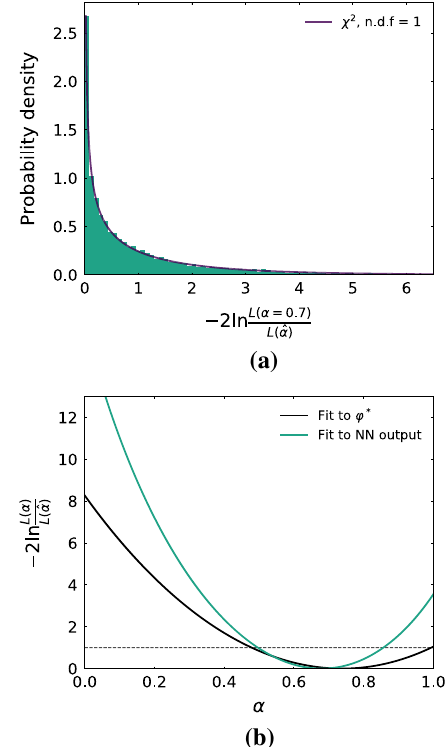
Fig. 6 a Distribution of the log-likelihood ratio − 2ln ( L (α = 0 . 7 )/ L ( ˆ α)) for the 10 , 000 test sets generated with α = 0 . 7. Overlaid is a χ 2 distribution for one degree of freedom. b Comparison of the log- likelihood ratio curves for the test dataset from Figs. 2b and 3b, using the network method (green) and the ϕ ∗ method (black). Intersection with the horizontal dashed line at − 2ln ( L (α)/ L ( ˆ α)) = 1 illustrates the 1 σ confidence intervals, which for this example are [ 0 . 48 , 1 . 0 ] for the ϕ ∗ method and [ 0 . 50 , 0 . 86 ] for the neural network